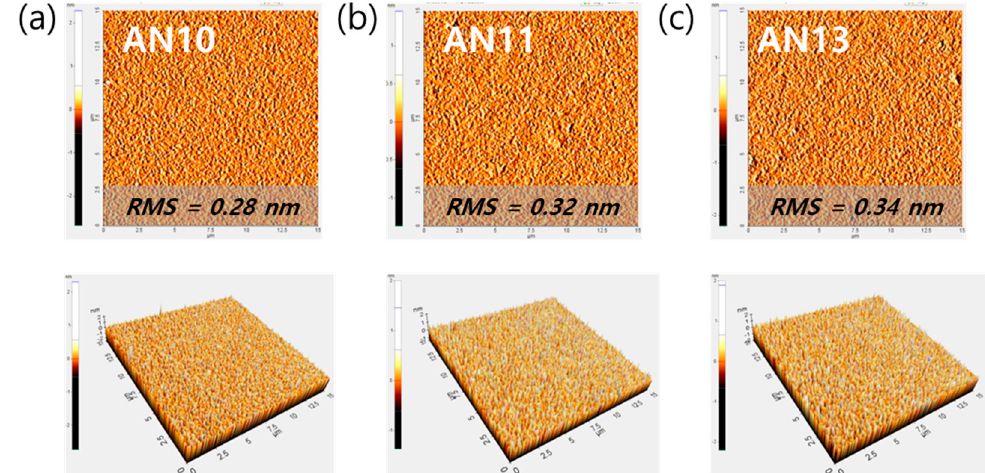
Figure 4. AFM topography (top) and three-dimensional views (bottom) of the surface of ( a ) AN10, ( b ) AN11, and ( c ) AN13 PEDOT:PSS.